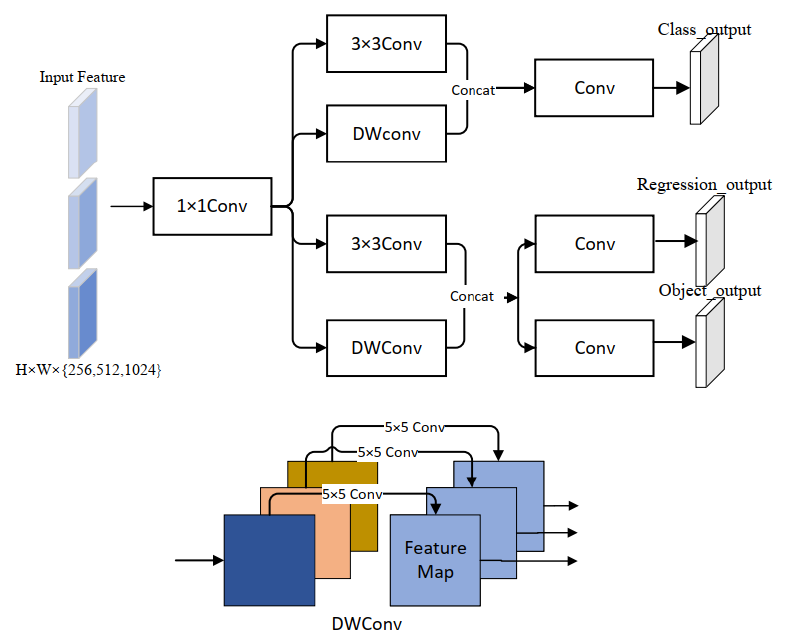
Figure 3. Lightweight decoupled head, H represents height, W represents